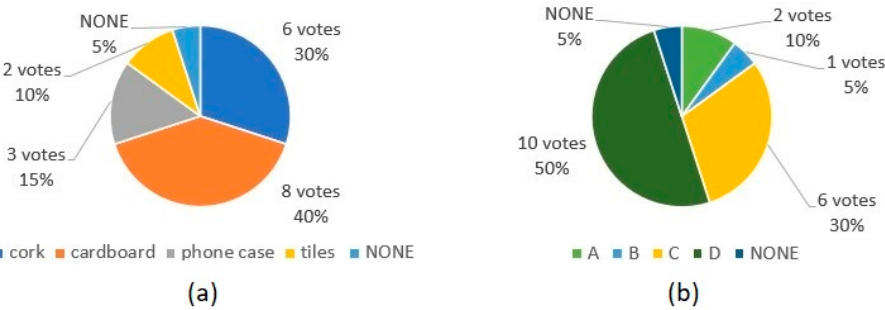
Figure 9. ( a ) Volunteers’ perception of the virtual texture displayed on the touchscreen for test 4. ( b ) Volunteers’ perception about the canvas that better represented the physical texture for test 4. According to survey questions from Appendix A.